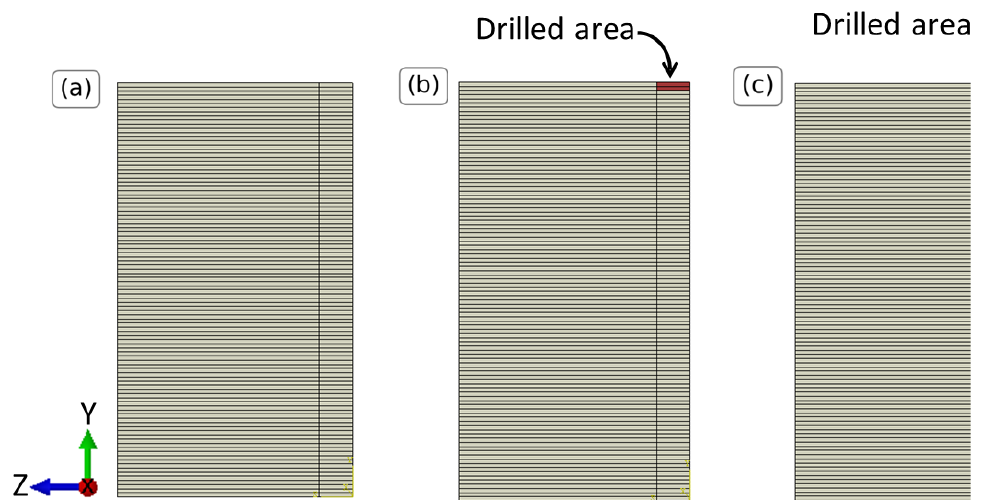
Figure 6. Y-Z plane view of the IHD test model illustrating the steel material (in white) and the void section (in red) for different drilling depths. ( a ) Drilling depth 0.0 mm, ( b ) drilling depth 0.4 mm, ( c ) drilling depth 2.0